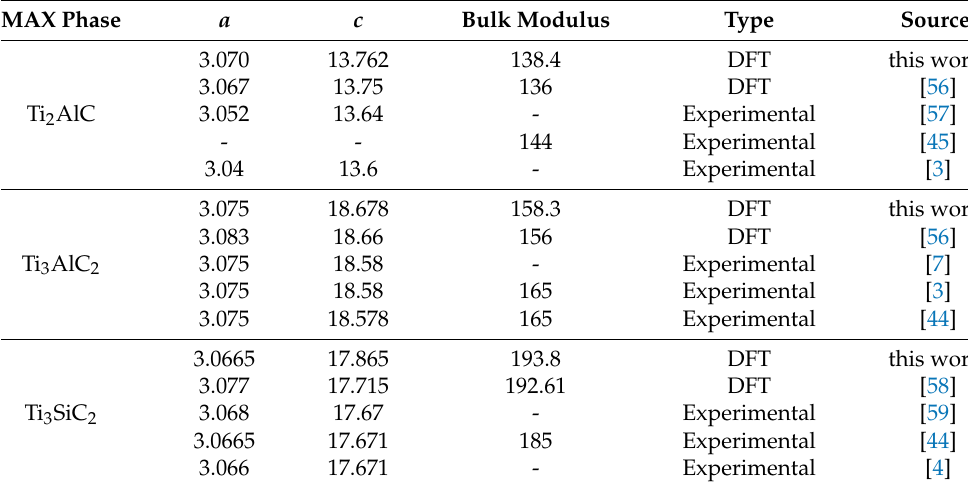
Table 1. Lattice parameters in Å and bulk modulus in GPa compared to theoretical and experimental values from the